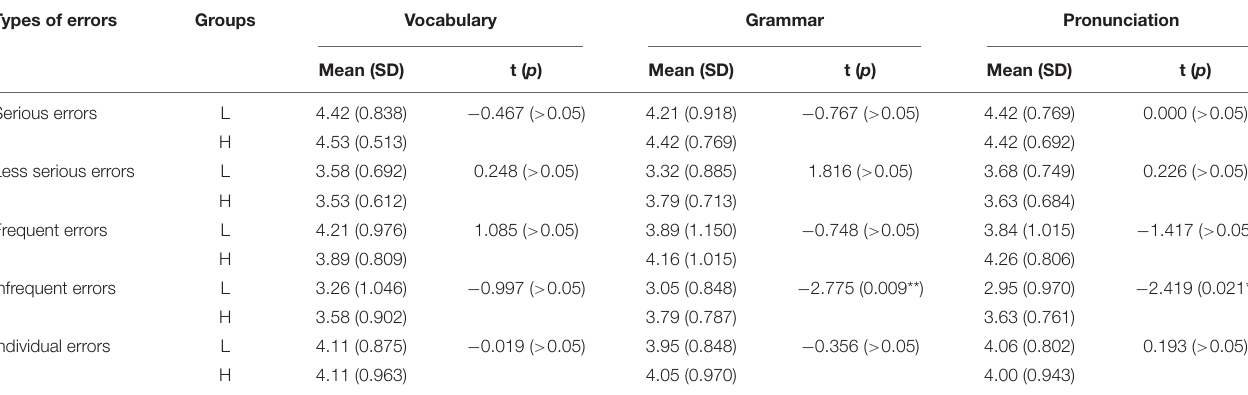
TABLE 2 | High- (H) and low-accuracy (L) group responses to types of errors that should be corrected. Types of errors